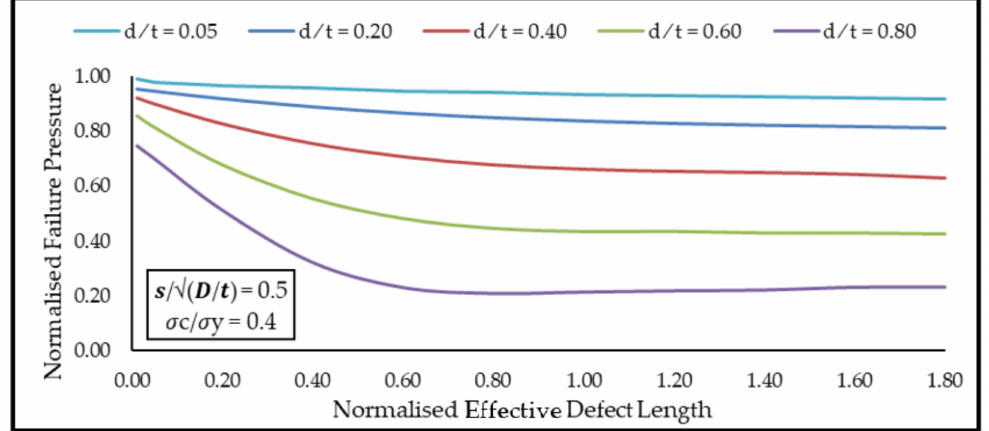
Figure 19. Normalized failure pressure predictions of the new assessment method against various normalized defect lengths for multiple normalized defect depths at constant normalized defect spacing of 0.5 and normalized axial compressive stress of